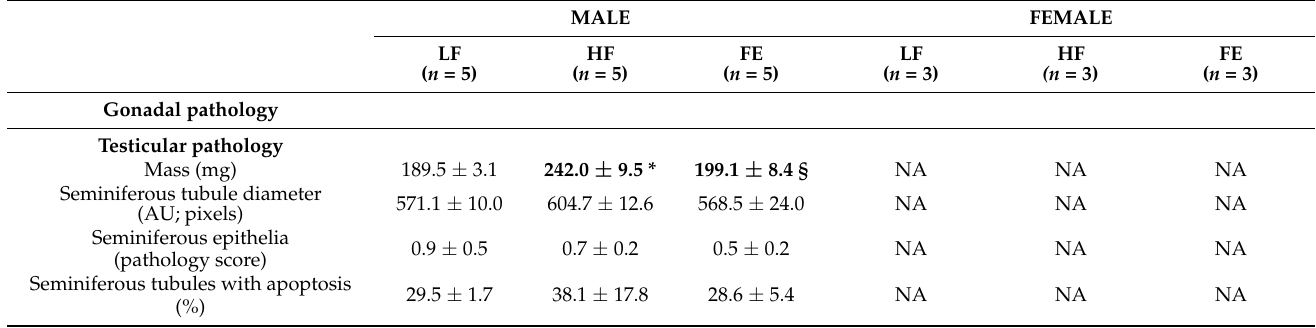
Table 3. Effect of multi-nutrient supplementation on gonadal morphology and pathology in a subset of Western diet-fed C57BL/6J